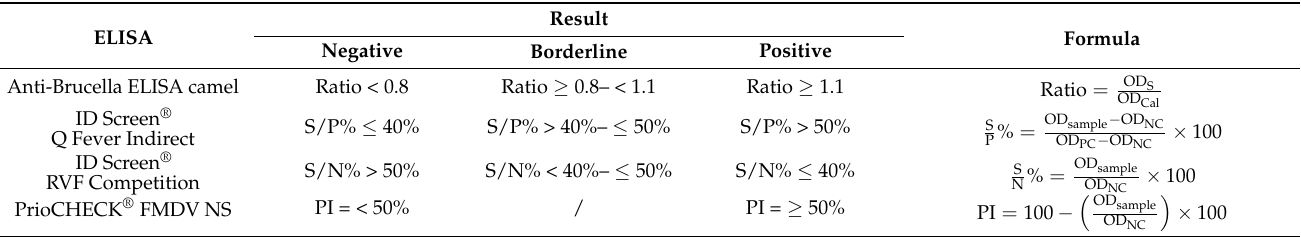
Table A1. Summary for semi-quantitative result interpretation for all ELISA kits used in this study. For all assays, extinction (OD) was measured at 450 nm. S = sample; Cal = calibrator; NC = negative control; PC = positive